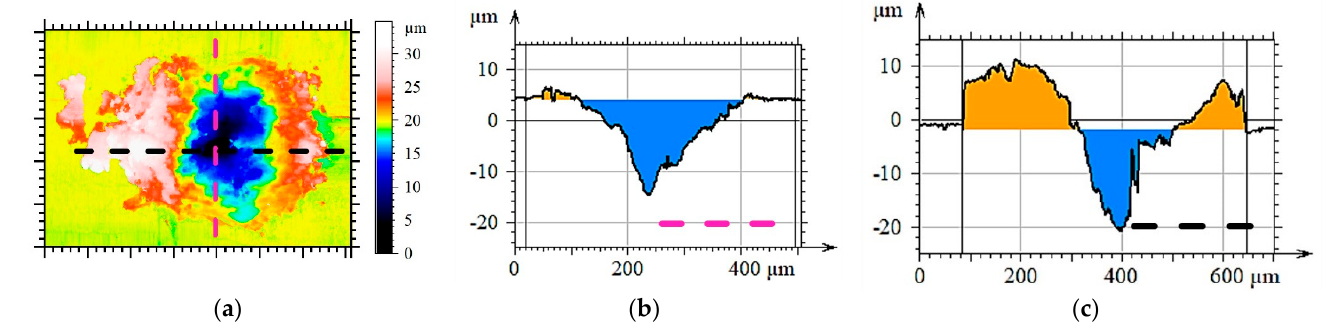
Figure 2. Topographic measurement of the surface of an electrical connectors stressed by fretting corrosion test: ( a ) Visual representation of the topography; ( b ) Vertical profile line within the contact zone; ( c ) Horizontal profile line within the contact zone.